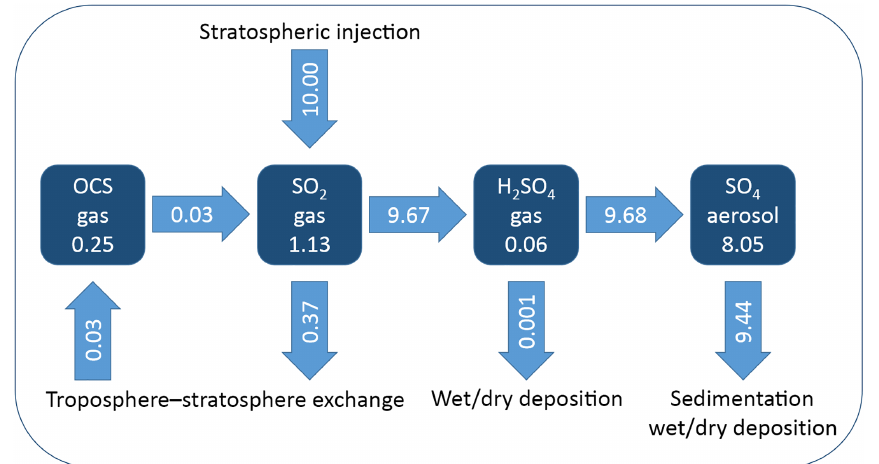
Figure 1. Annual mean stratospheric burdens (boxes, in TgS) and fluxes (arrows, in TgSyr − 1 ) of the represented sulfur species from the fifth year (quasi-steady state) of the STANDARD experiment. Minor discrepancies in the fluxes indicate that the steady state is not entirely reached after 5 years.